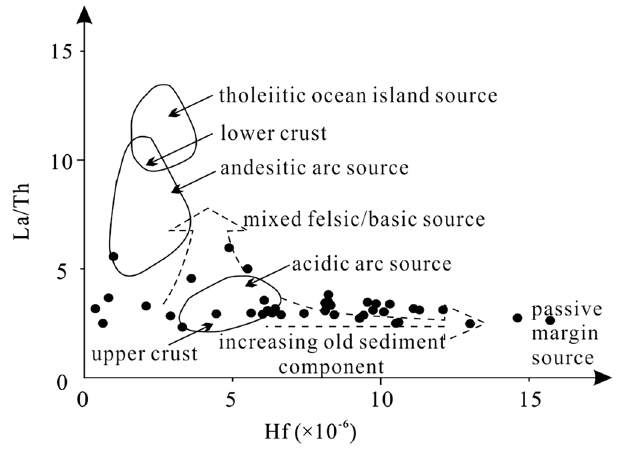
Figure 7. La/Th-Hf discriminatory plot (modified after Floyd et al. 54 ) of late Cretaceous samples from the lower Zhoutian Formation, Jitai